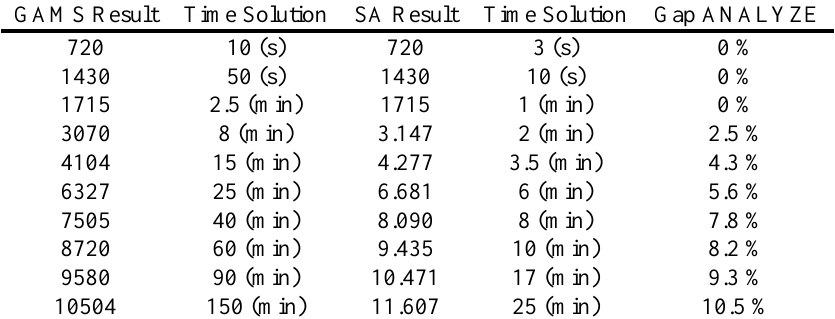
Table 3. Compare the results of problem solving with GAMS and SA